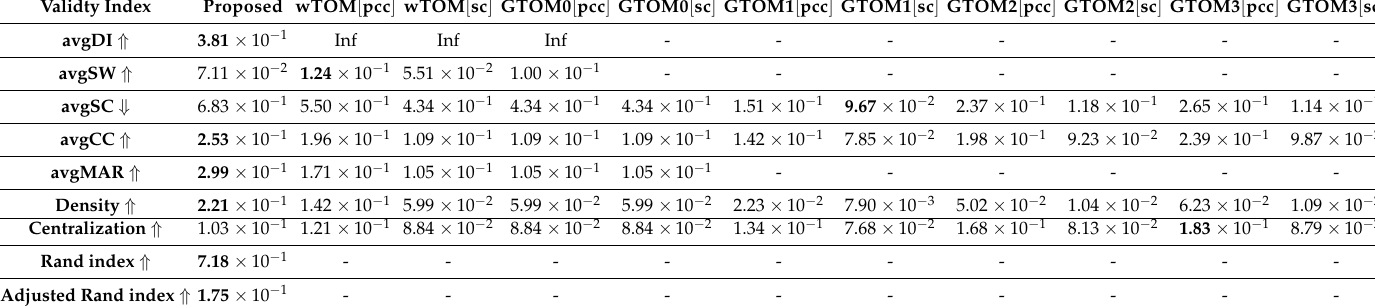
Table 6. Comparison of proposed rule-based gene-module detection method and other existing geneset-based gene-module detection methods in the second simulation study for the LUSC